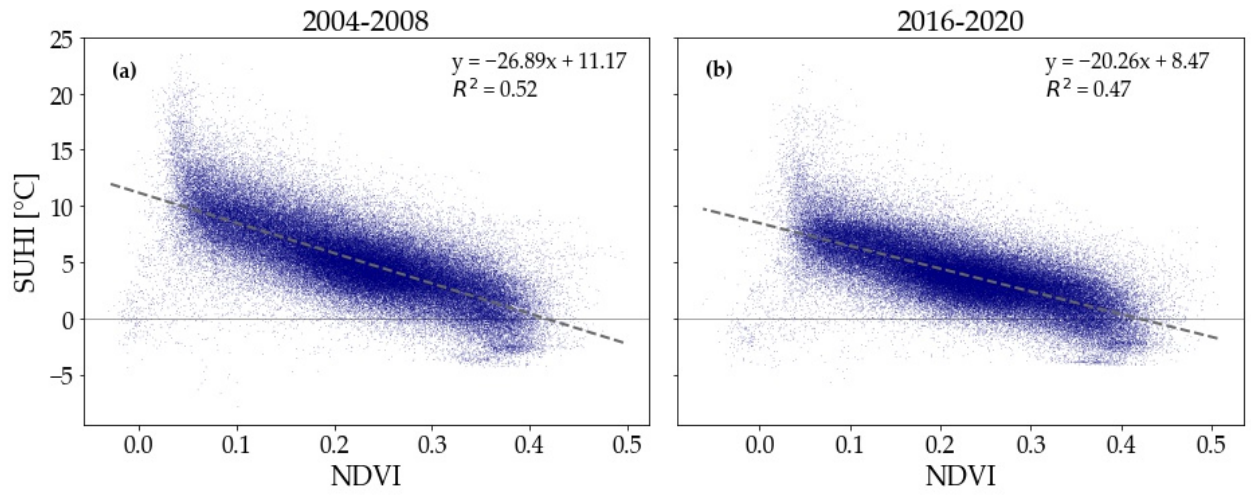
Figure 2. Scatterplots of the correlation between Normalised Difference Vegetation Index (NDVI) and surface urban heat island (SUHI) in the urban area of Stuttgart averaged over ( a ) 2004–2008 and ( b ) 2016–2020. Each dot represents a Landsat pixel within the administrative boundaries of Stuttgart. ∆ SUHI clearly correlates with the initial LST in 2004–2008 (Figure 3). Areas with high LST in 2004–2008 exhibit a disproportionately stronger decrease in SUHI than areas with lower LST. As a result, the SUHI variance within the urban area decreased in 2016–2020 compared to 2004–2008.